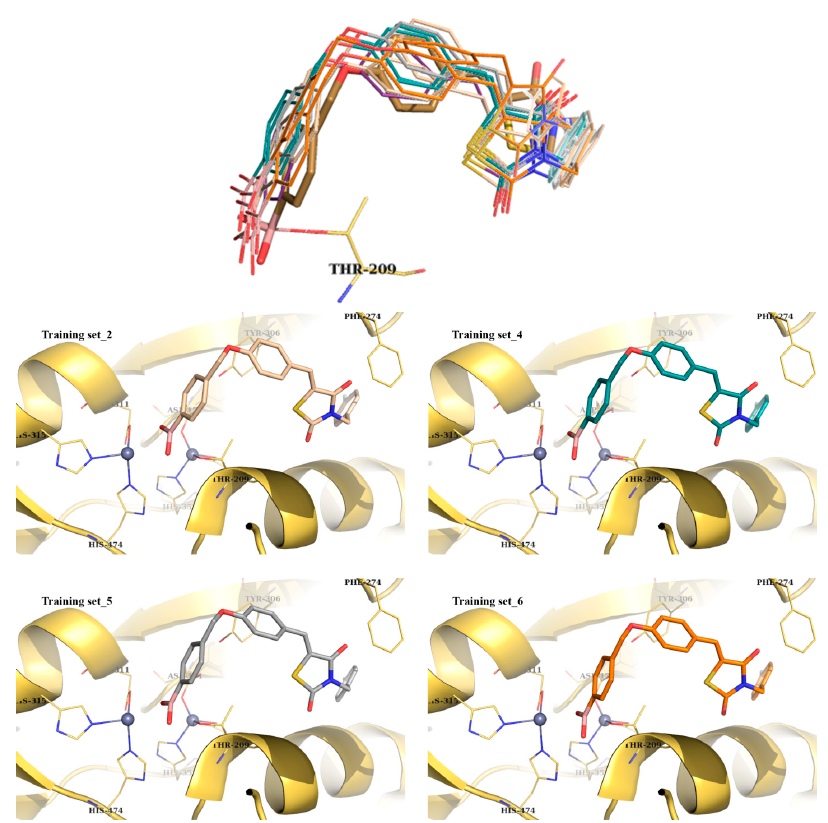
Figure 2. Overlay representation of query compound HA155 as gold sticks with Thr209 residue present and the predicted solutions as colored lines ( top ); best scoring poses of modeled compound HA155 within the active site of ATX ( bottom ). The figure was obtained by PyMol version 1.4.1 [30].